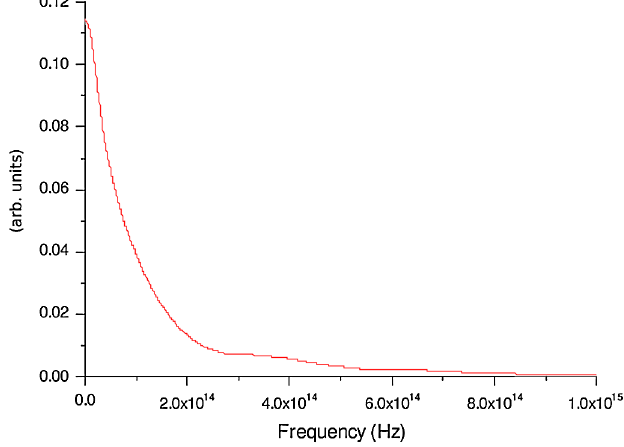
FIG. 9. (Color) Integrated